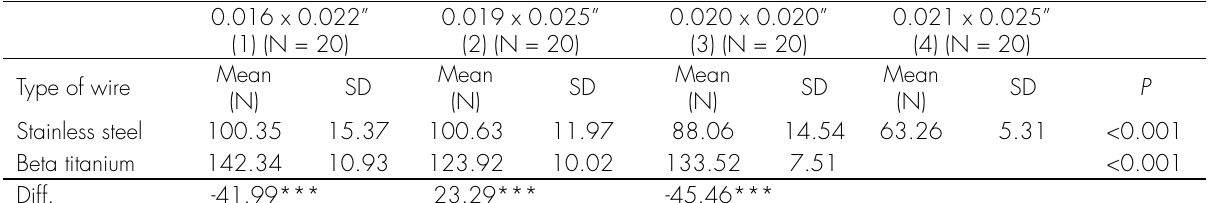
Table IIIa. Mean force levels in newtons (N) required to cause axial dislodgement of nickel titanium compression hooks placed on 0.016 × 0.022” (1), 0.019 × 0.025” (2), 0.020 × 0.020” (3) stainless steel and beta titanium arch wires, and the 0.021 × 0.025” (4) stainless steel wire. Descriptive data and results of the one-way analysis of variance ( p ). Diff. = differences between the mean values in the stainless steel and beta titanium groups data in the respective wire size groups.